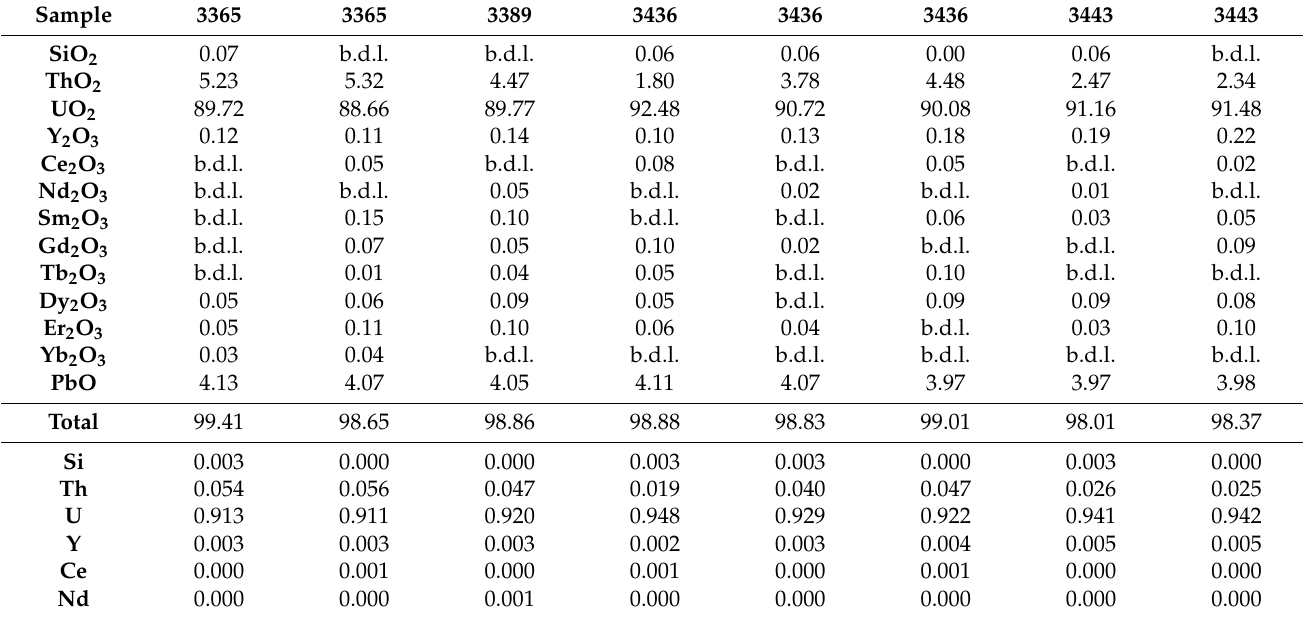
Table 4. Representative results (wt%) of electron microprobe analyses of uraninite from Podles í . Formulae (in atoms per formula unit, apfu ) based on 2 oxygen atoms.